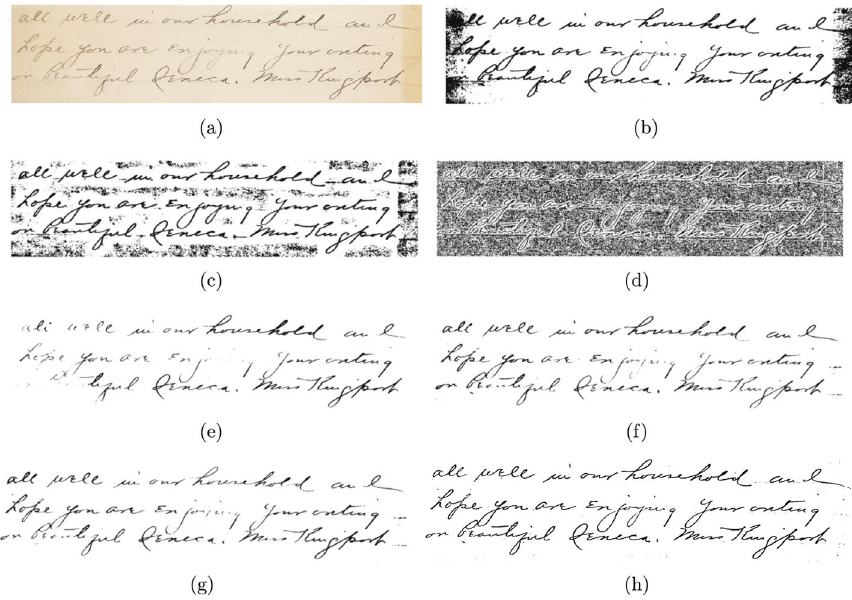
Fig. 9 Binarization results of a sample image by different methods. a Original image, b Otsu [3], c Niblack [5], d Bernsen [4], e Sauvola [6], f Singh [8], g Lu [9], and h proposed